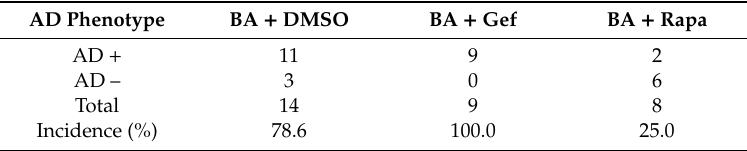
Figure 1. Effect of cell cycle inhibitors on aortic dissection (AD). ( A , B ) Effects of rapamycin and gefitinib on the expression of cyclin D3 ( A ) and macroscopic findings ( B ) in a murine model of AD. Scale bar: 5 mm. ( C , D ) Quantitative analysis of the e ff ect of rapamycin on AD lesion length ( C ), p70 S6 kinase (S6K), activated (phosphorylated) S6K (pS6K), and cyclin D3 ( D ). The figures in parentheses indicate the numbers of independent observations. * p < 0.05, ** p < 0.01, *** p < 0.001. Among the multiple experimental groups, all comparisons between two groups were tested and for simplicity only those with statistically significant di ff erences are indicated. Table 1. E ff ect of cell cycle inhibitors on AD